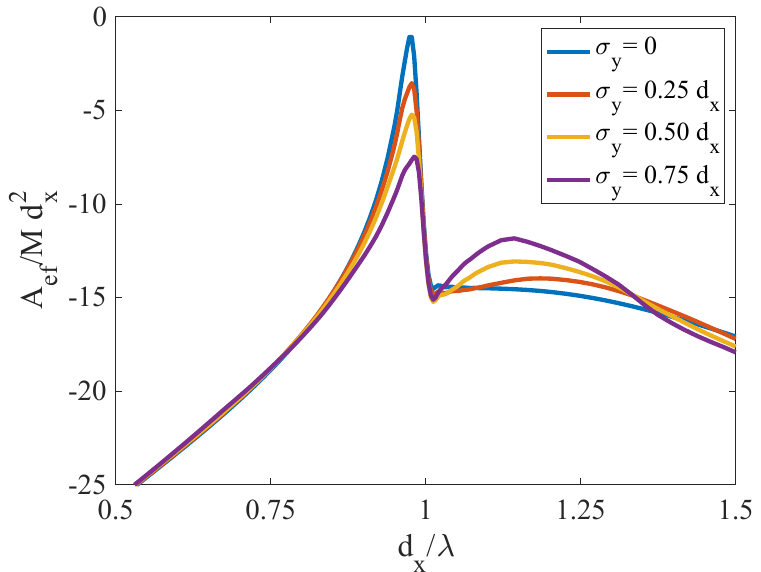
Figure 7. Normalized effective transmitting area of a finite chain of M slots with l s = 0.4 d x , w s = 0.05 d x and with y ci given by a set of random numbers following a normal distribution with mean 0 for different values of standard